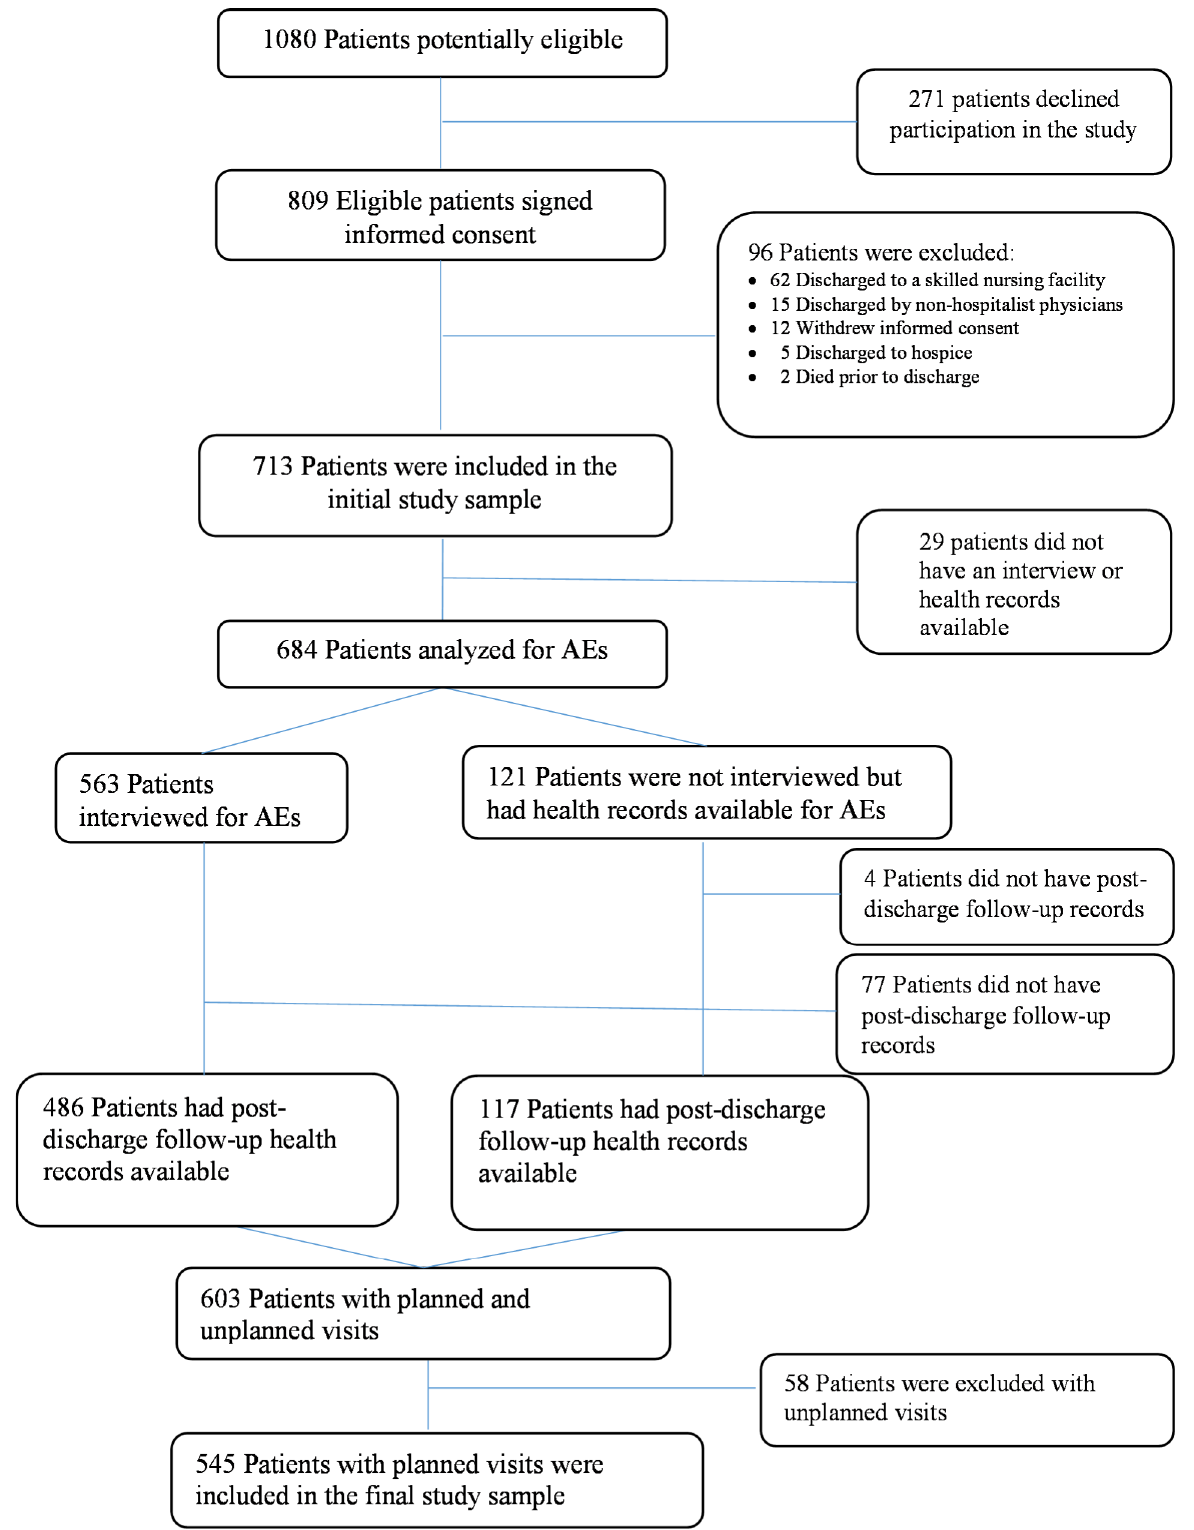
Fig 1. Flow of participants through the study. AEs = adverseevents.